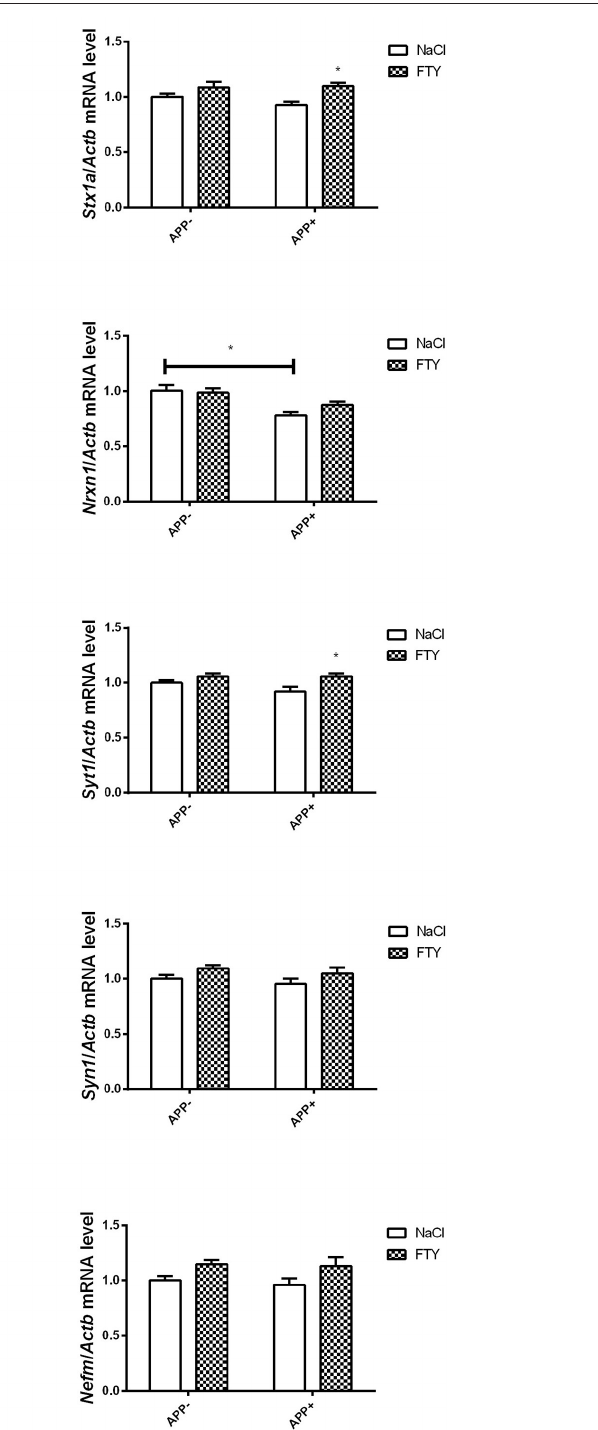
Frontiers in Molecular Neuroscience |